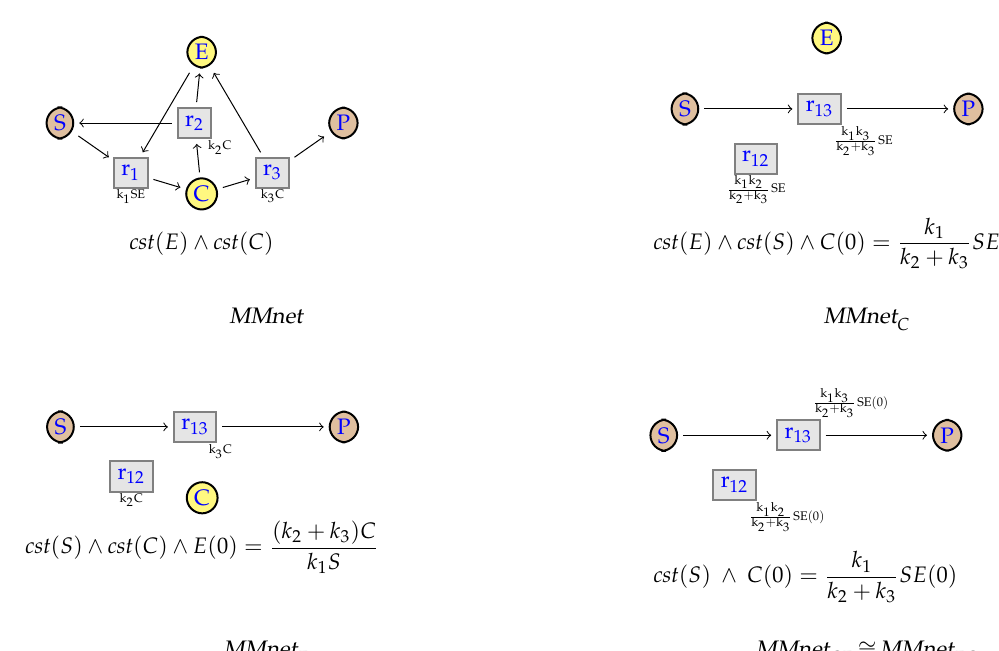
and MMnet are obtained E C is obtained after CE is obtained by inverting the order of EC